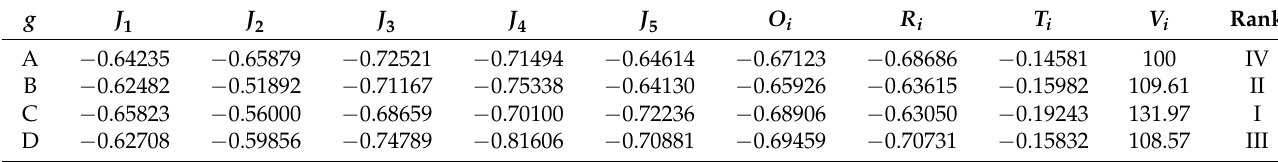
Table 3. The score function and ranking of